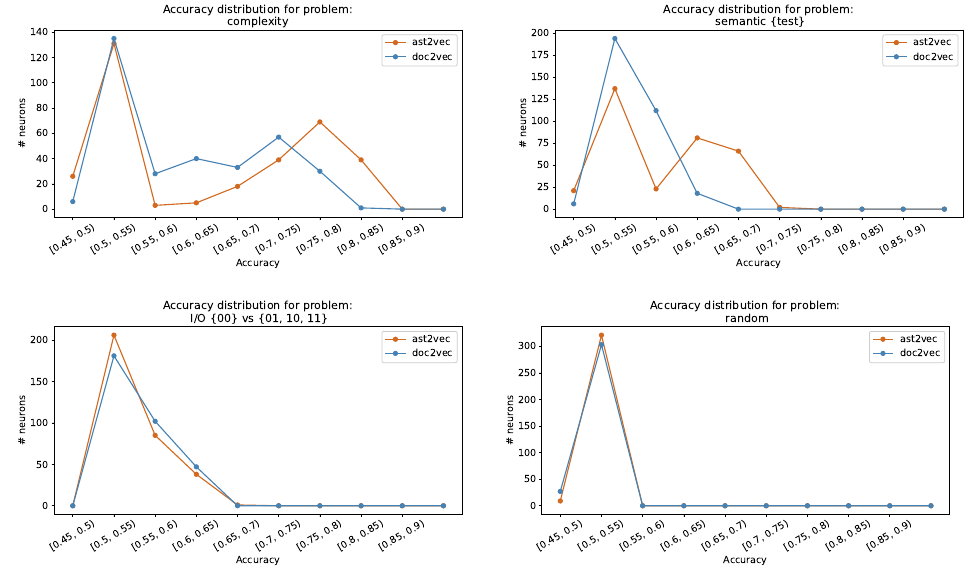
Figure 2. Classification accuracies reached by the neurons on different problem instances (see Section